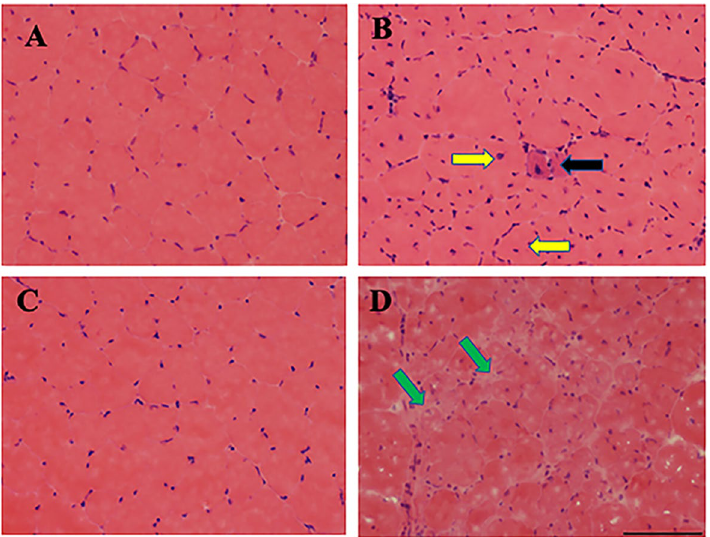
Figure 1. Skeletal muscle degeneration is observed in the mouse model of DMD. Hematoxylin and Eosin (H&E) staining of TA muscle cross sections from 3- and 12-month-old control (C57BL/10ScSnJ) ( A , C ) and mdx (C57BL/10ScSn-Dmd < mdx > /J) ( B , D ) mice. The 3-month old control muscle cross-section shows normal fiber morphology including circular shape and absent central nuclei ( A ), whereas 3-month old mdx mice show muscle degeneration denoted by muscle fibers with central nuclei observed and smaller diameter (yellow arrows), atrophied muscle (smaller than the neighboring fibers without central nuclei, black arrow), and more prevalent nuclei which represents inflammatory cells ( B ). Control mice at 12-months old ( C ) are compared to the 12-month old mdx mice ( D ) where muscle degeneration is much more dramatic, as evident by the absence of normal muscle fiber structure in almost all areas of the section; the muscle structure is often taken over by fatty and necrotic tissues, as indicated by the unstained/white areas (green arrows). Scale Bar: 100